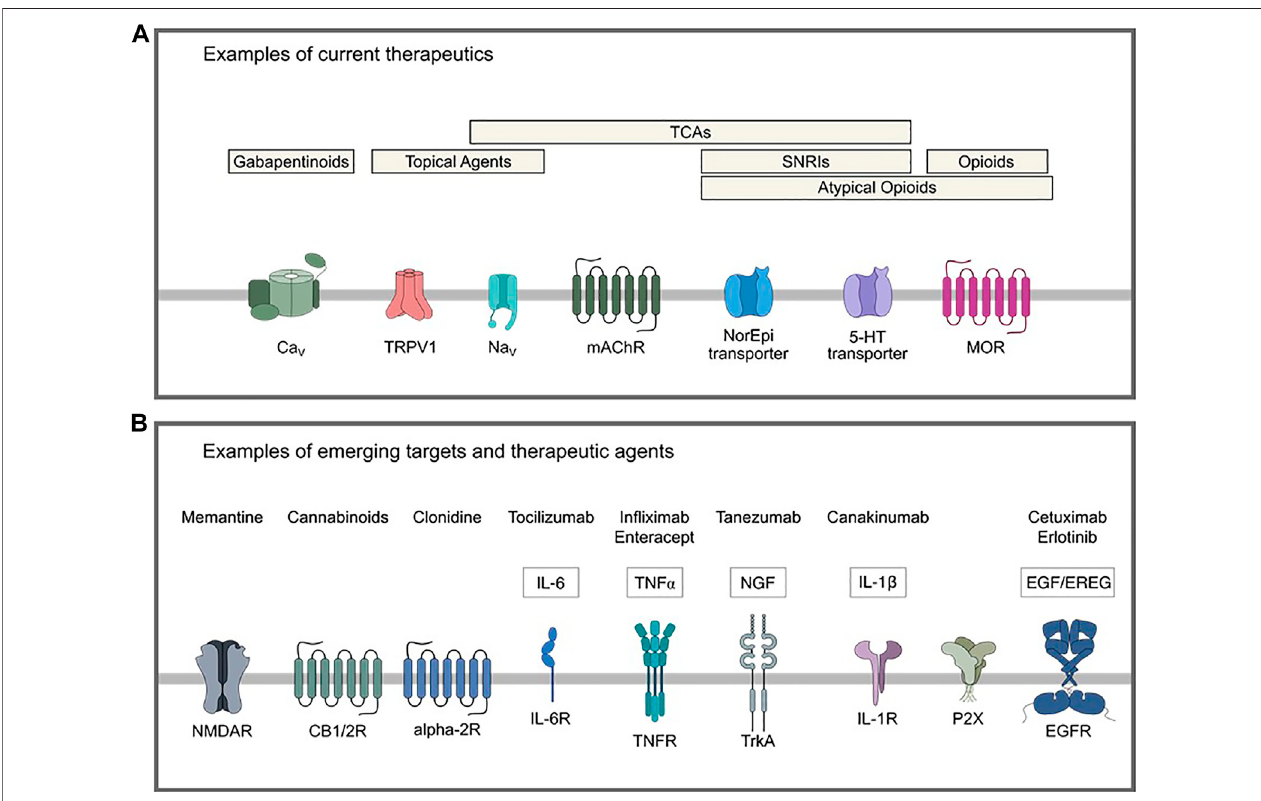
FIGURE1| Examplesofcurrentandemergingpotentialtherapeuticsfortreatmentofneuropathicpain. (A) Currenttherapeuticsincludegabapentinoidsthatacton the α 2 δ -1calciumchannelsubunit,topicalagentswithtargetssuchasTRPV1orvoltage-gatedsodiumchannels,opioids,atypicalopioids(mixed/partialagonists,some of which have actions as an SNRI or NI), TCAs that act on various distinct targets such as serotonergic, adrenergic and cholinergic systems and fast voltage-gated sodium channels, and SNRIs. (B) Examples of emerging potential targets and therapeutics for neuropathic pain. 5-HT: 5-hydroxytryptamine, CB1/2: cannabinoid receptor type 1/2, Ca V : voltage-gated calcium channel, EGF: epidermal growth factor, EGFR: epidermal growth factor receptor, EREG: epiregulin, IL: interleukin, IL-6R: interleukin-6 receptor, IL-1R: interleukin-1 receptor, mAChR: muscarinic acetylcholine receptor, MOR: mu-opioid receptor, Na V voltage-gated sodium channel, NGF: nervegrowth factor, NI:norepinephrine reuptakeinhibitor, SNRI: selective serotonin reuptake inhibitor, TCA: tricyclic antidepressant, TNF: tumor necrosisfactor, TNFR: tumor necrosis factor receptor, TrkA: tropomyosin receptor kinase A, TRPV1: transient receptor potential cation channel subfamily V member